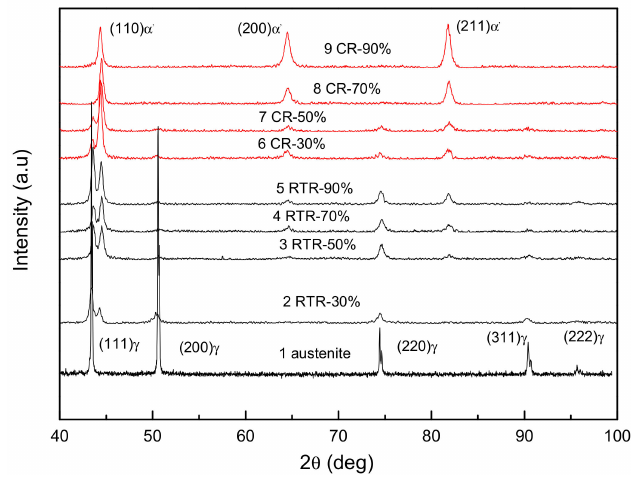
Figure 1. XRD patterns of the 316LN austenitic stainless steel before and after deformation at different temperatures (the data of CR is from [14]).